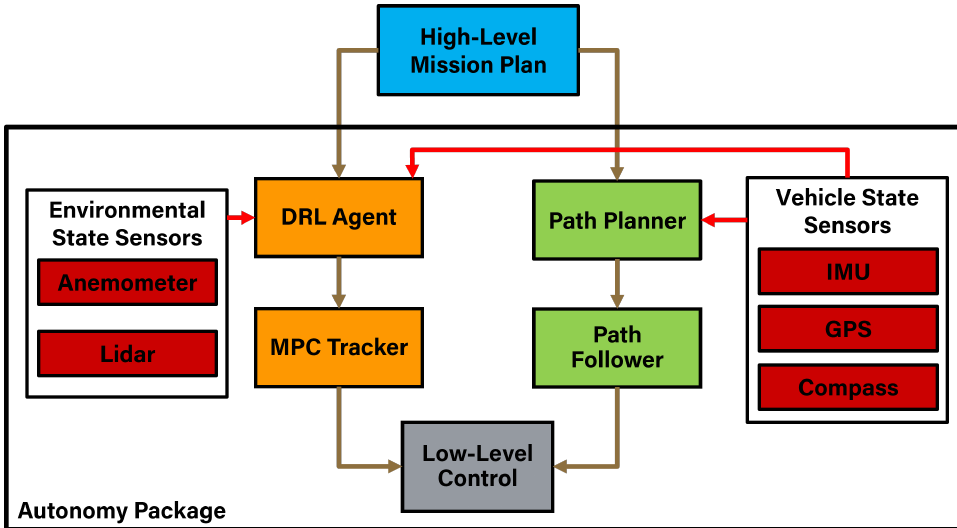
Figure 2. Autonomy package including all the control levels and